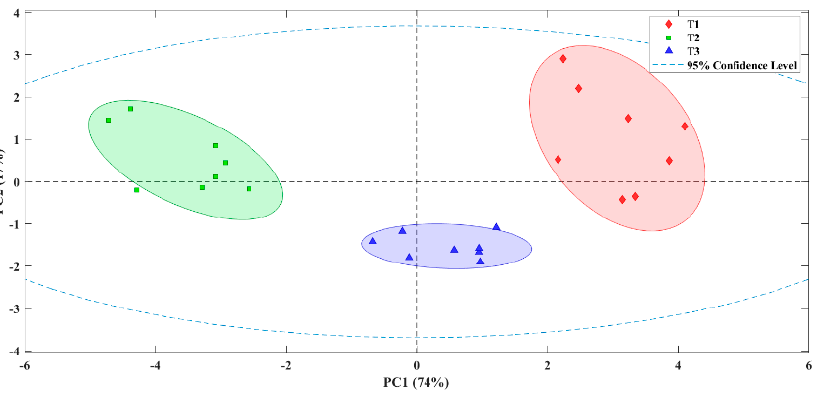
Figure 3. Score plot obtained from the PCA of Californian-style black olives prepared with Carao. T1: olives with ferrous gluconate stuffed with 0% of ‘Mojo pic ó n’; T2: olives with fresh Carao stuffed with 0% of ‘Mojo pic ó n’; T3: olives with lyophilized Carao stuffed with 0% of ‘Mojo pic ó n’. Subsequently, another PCA was carried out with olives in which colour was fixed with fresh and lyophilized Carao stuffed with hydrocolloid flavoured with ‘Mojo pic ó n’ at different concentrations (Figure 4). The E-nose was able to differentiate olives with fresh Carao and ‘Mojo pic ó n’ added. The PC1 explained 94.0% of the total variance of the data, while PC2 explained 3.0% (Figure 4a). The E-nose was also able to discriminate table olives prepared with lyophilized Carao with flavoured hydrocolloid at the different concentrations. The PC1 explained 97.0% of the total variance of the data, while PC2 explained 2.0% (Figure 4b). With this procedure, the negative sensory effects of the addition of Carao during preparation of Californian-style black olives were masked by stuffing olives with flavoured hydrocolloid. The E-nose was used to evaluate its discriminating power as support for the tasting panel. We must highlight that the exploratory PCA was able to differentiate between stuffed olives with different concentrations of ‘Mojo pic ó n’ aroma. Similar results were found when using fresh and lyophilized Carao at different concentrations of the added aromas. S á nchez et al. [27] showed similar results because they separated stuffed black olives with and without added flavouring. This indicates that ‘Mojo pic ó n’ aroma added at a low concentration (2%) is enough to fully achieve our objective of masking the initial aroma of Californian-style black olives prepared with Carao. For all of that, this strategy could be interesting for table olives sector to produce a better-quality product without organoleptic defect. cross-validation. The confusion matrix of the PLS-DA model (Table 4) shows that the sum of the diagonal elements gave a hit rate of 100%. Eight samples from each class were used to construct the model, which allowed to discriminate Californian-style table olives whose colour was fixed with ferrous gluconate and/or fresh and lyophilized Carao. The characteristic aroma of these olives allowed the different